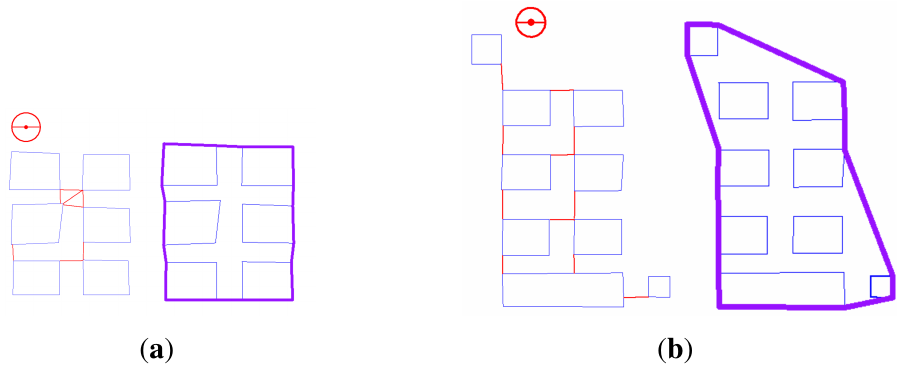
Figure 3. Creating polygonal boundaries of objects according to inaccessible gaps between the objects (the circle denotes a user with tools, and red lines represent inaccessible gaps). ( a ) The polygonal boundary for the six objects without inner rings; ( b ) the simple boundary for the nine